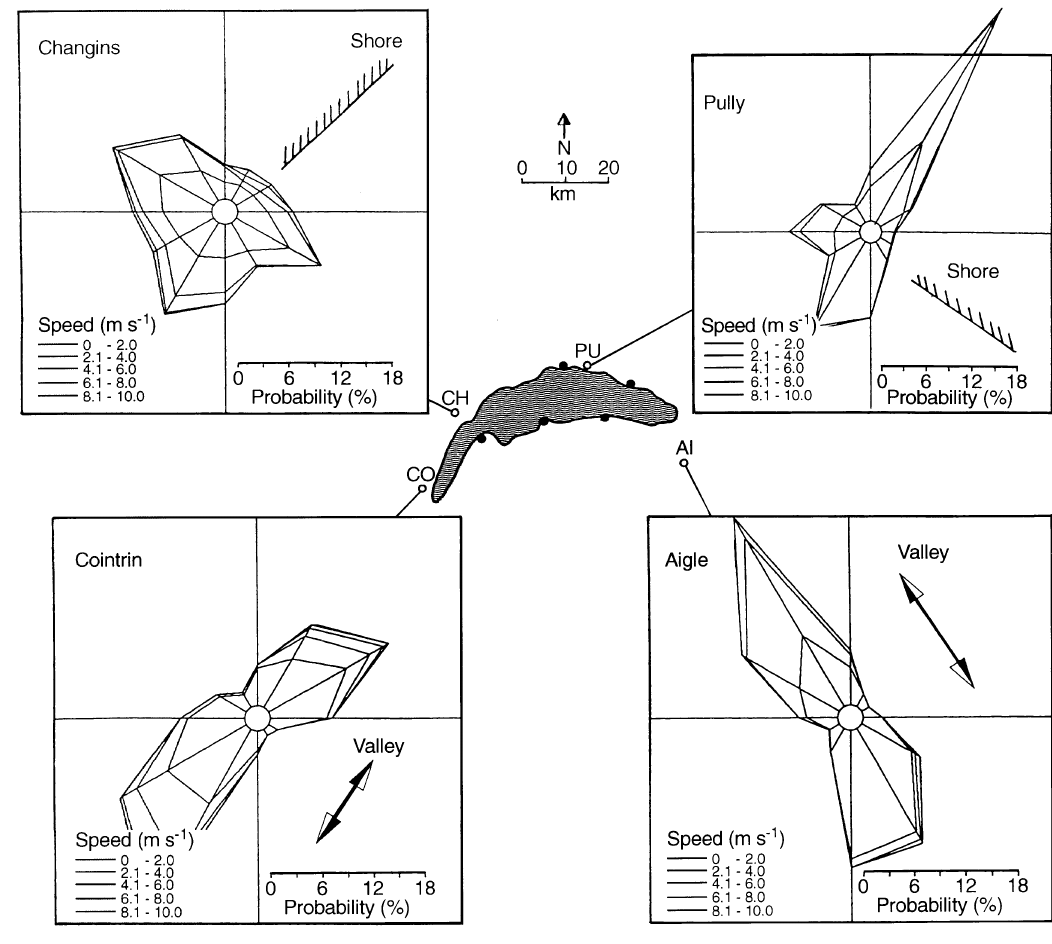
Fig. 2. Rose diagrams of the winds at the four Swiss Meteorological stations CO , CH , P ” and AI . Winds are shown as ‘‘coming from’’ The histograms in Fig. 3 show that during summer the wind speeds were predominantly ( 4 m s (cid:126)(cid:49) (about 80 — 90% of the time). In the eastern half and the central part of the lake basin, maximum winds are about 4 — 6 m s (cid:126)(cid:49) and occurred for 5 — 10% of the time. In the western half of the lake maximum winds of about 4 — 8 m s (cid:126)(cid:49) occurred about 10 — 15% of the time. Thus, along the northern boundary of the lake, winds appear generally stronger in the western